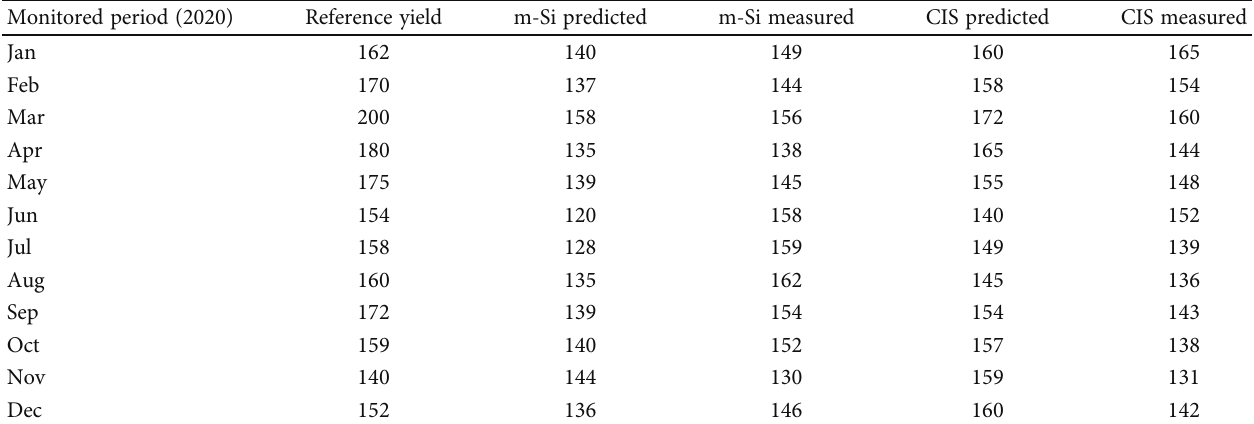
Table 7: CIS and m-Si PV modules ’ measured and predicted fi nal yield.